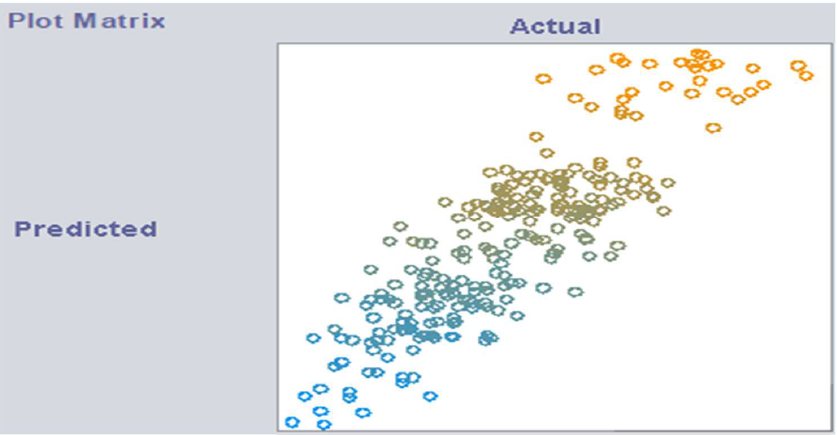
Energies 2022 , 15 , x FOR PEER REVIEW Figure 7. Plot of predicted and actual values for one-parameter subset. Figure 7. Plot of predicted and actual values for one-parameter subset.